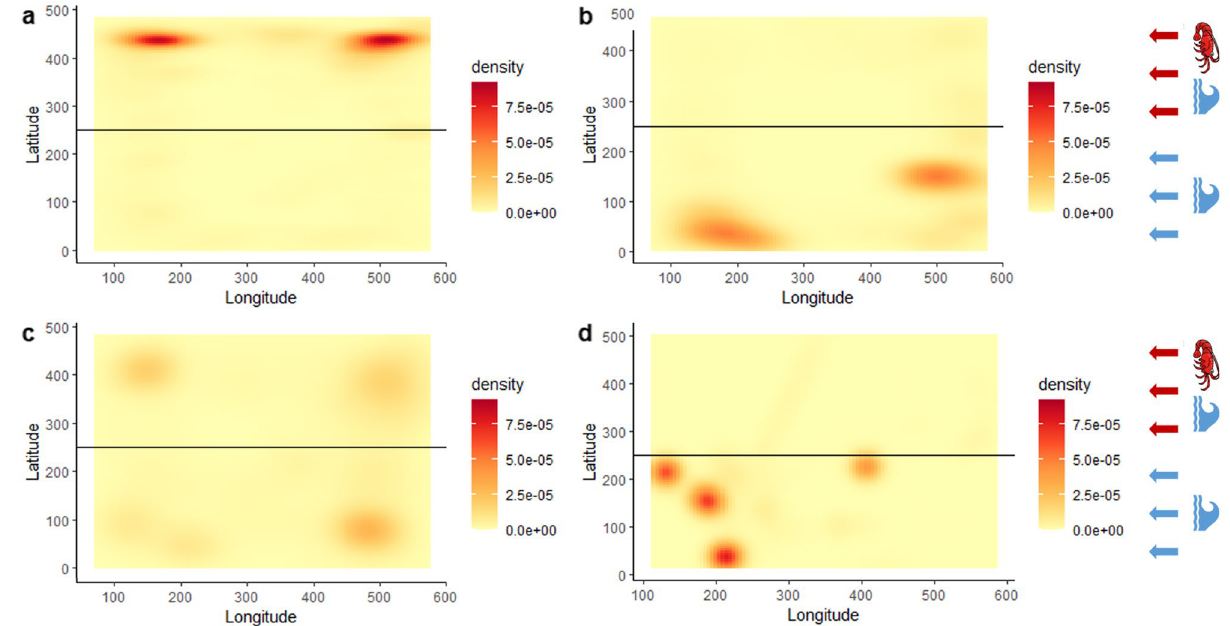
Figure 3. Density plot for number of detection points of lobster coordinate position in choice arena during 10 min exposure to conspecific moulting cues. One treatment group per density plot, ( a ) inter-moult/naïve (n = 6), ( b ) inter-moult/familiar (n = 5), ( c ) post-moult/naïve (n = 6), ( d ) post-moult/familiar (n = 5). In each plot conspecific cue current is present above the horizontal line and water only current is present below the line. Water flow is from right to